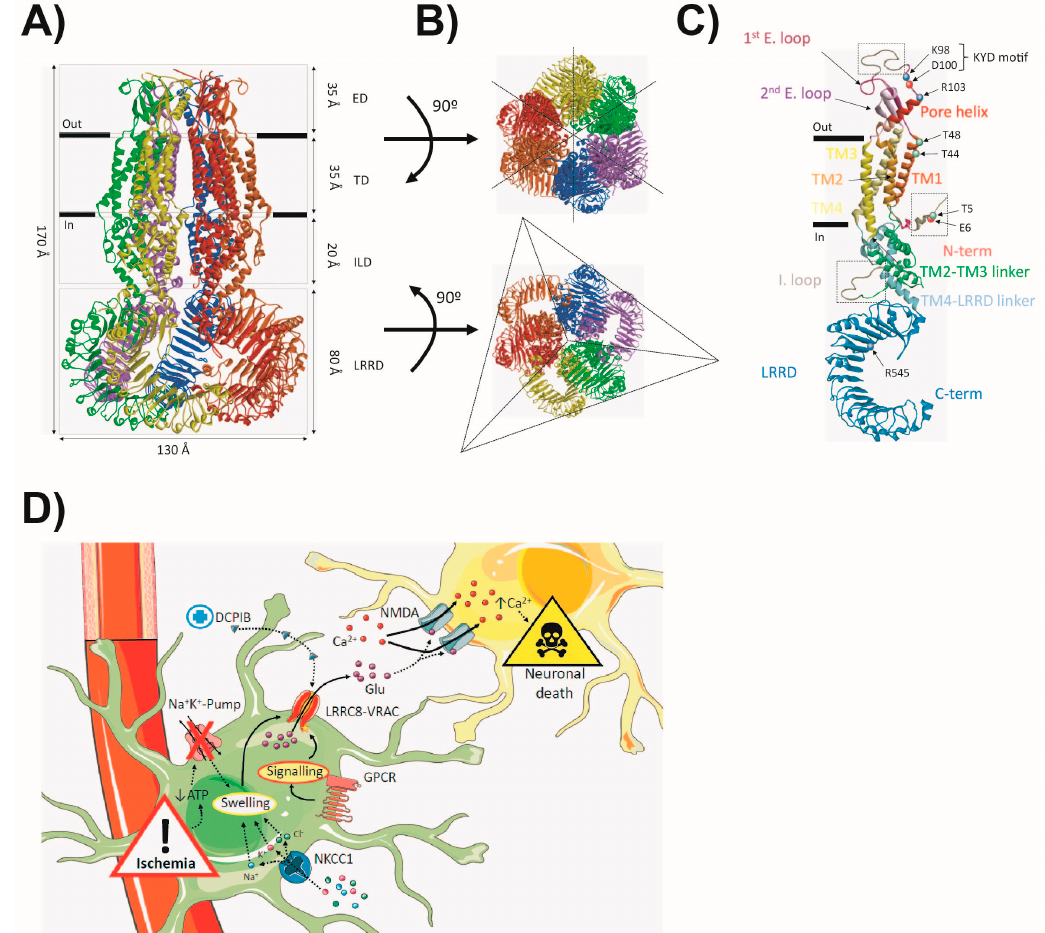
Figure 3. The VRAC. ( A ) The cryo-based model of the 8A-VRAC viewed from the membrane plane. The different subunits of the hexamer are highlighted in different colours, and domain layers are indicated by dashed rectangles. ( B ) Extracellular (top) and intracellular (bottom) views of the 8A-VRAC model. Dashed lines highlight the symmetry axis of the structures, with a six-fold symmetry axis observed in the top view, and a three-fold symmetry axis in the bottom view (LRRD). ( C ) Representation of a single LRRC8A subunit. Different helices and domains are indicated in different colours. Dashed squares delimit unresolved regions in the structure. Relevant positive residues (blue), negative (red) and polar (green) are indicated with coloured spheres. ( D ) The hypothetical model of the pathophysiological role of the astrocytic VRAC in ischaemia. Ischaemic conditions lead to depletion of intracellular ATP due to unsustainable oxidative metabolism, triggering the inactivation of the Na + /K + -pump, and subsequently cell swelling. NKCC1 cotransporter activity could further contribute to cell swelling. Astrocyte swelling triggers the opening of the LRRC8-VRAC mediating glutamate efflux. Glutamate build-up in the ischaemic penumbra produces its excitotoxic effect